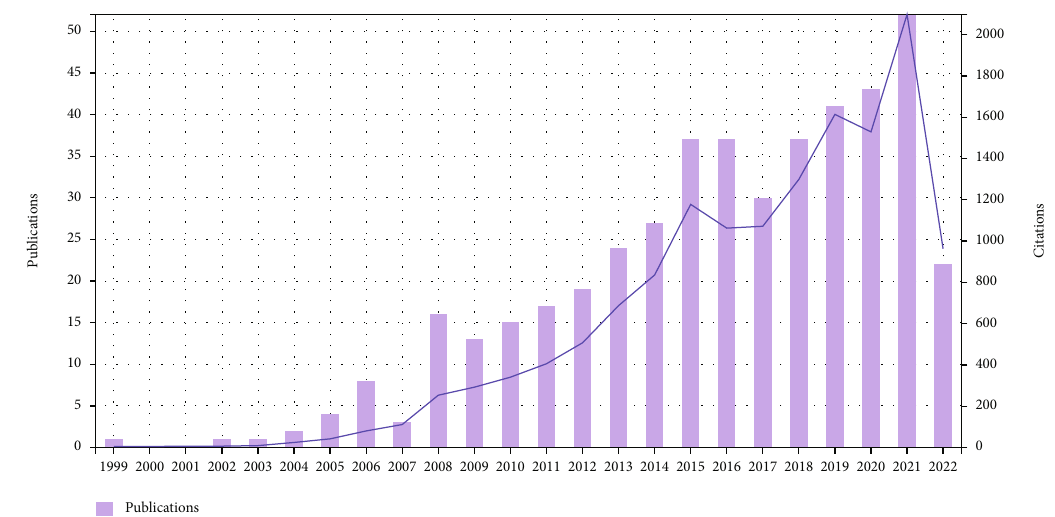
Figure 1: Annual publications and sum of times cited per year on stem and progenitor cells in intervertebral